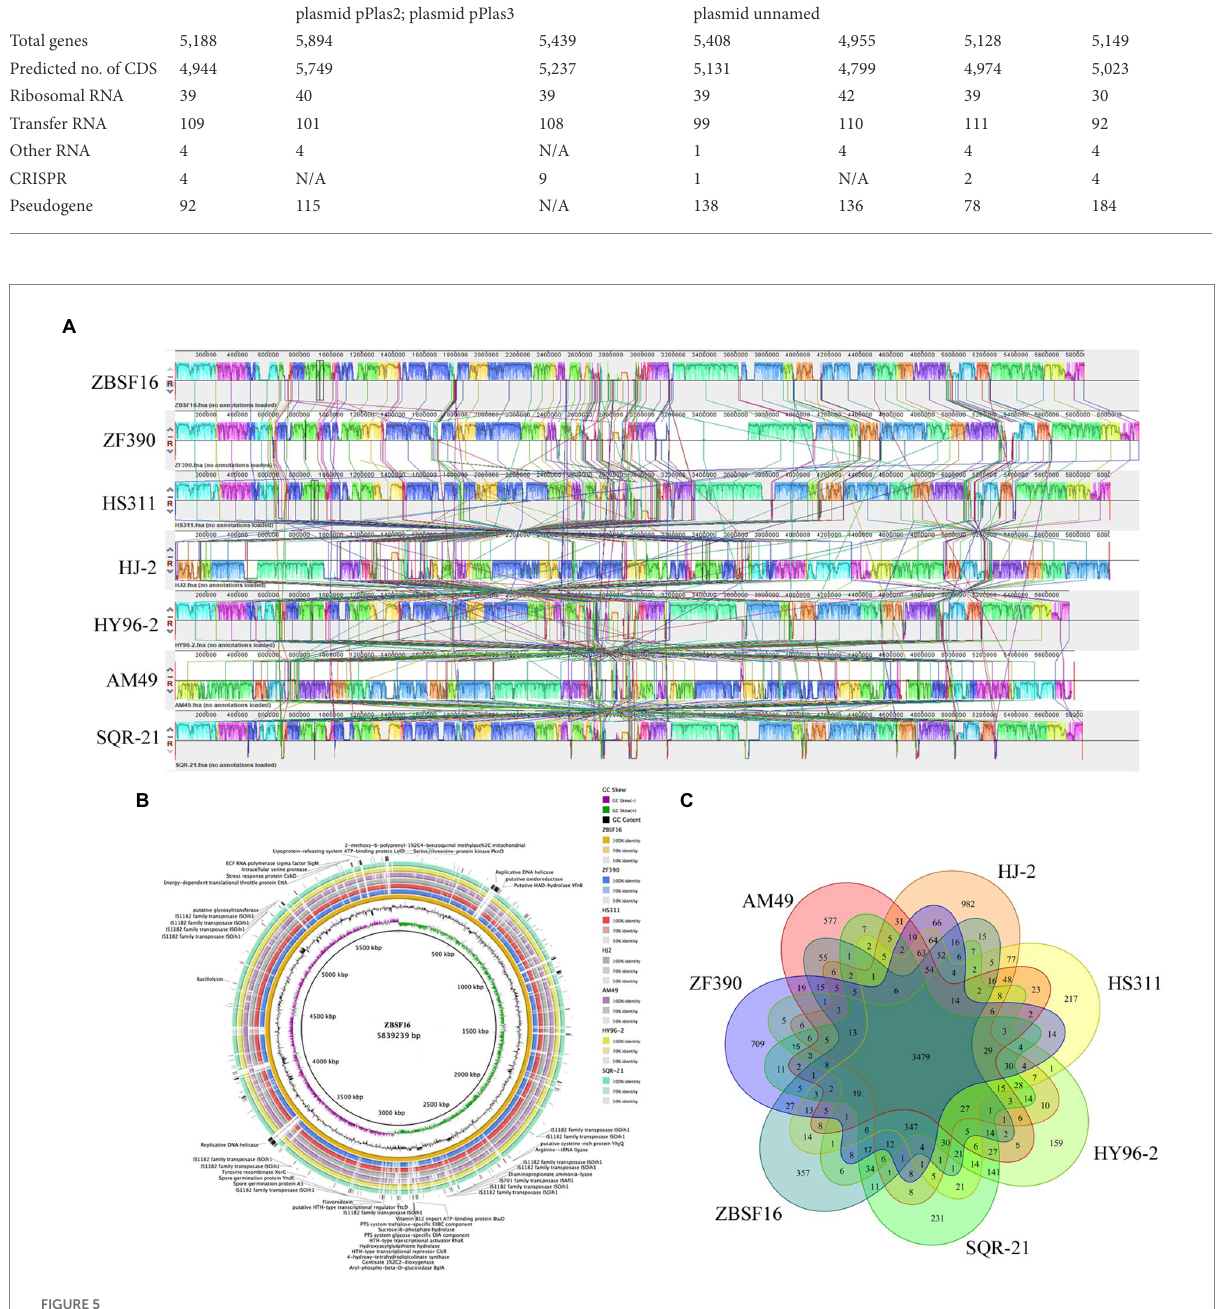
FIGURE 5 Comparison of Paenibacillus peoriae ZBSF16 genome sequences against six other Paenibacillus genome sequences. (A) Synteny analysis of P. peoriae ZBSF16 with the P. peoriae ZF390, P. peoriae HS311, P. peoriae HJ-2, P. polymyxa HY96-2 P. polymyxa SQR-21 and P. kribbensis AM49 genomes. Pairwise alignments of the genomes were generated using MAUVE. The genome of strain ZBSF16 was used as the reference genome. Boxes with the same color indicate syntenic regions. Boxes below the horizontal strain line indicate inverted regions. Rearrangements are shown by colored lines. Scale is in nucleotides. (B) Pangenome analysis with closely related strains identified the unique genes present in the query genomes that are highlighted in the outermost circle, the strain ZBSF16 as the query genome is placed in the innermost circle. (C) Venn diagram showing the number of clusters of orthologous genes shared and unique